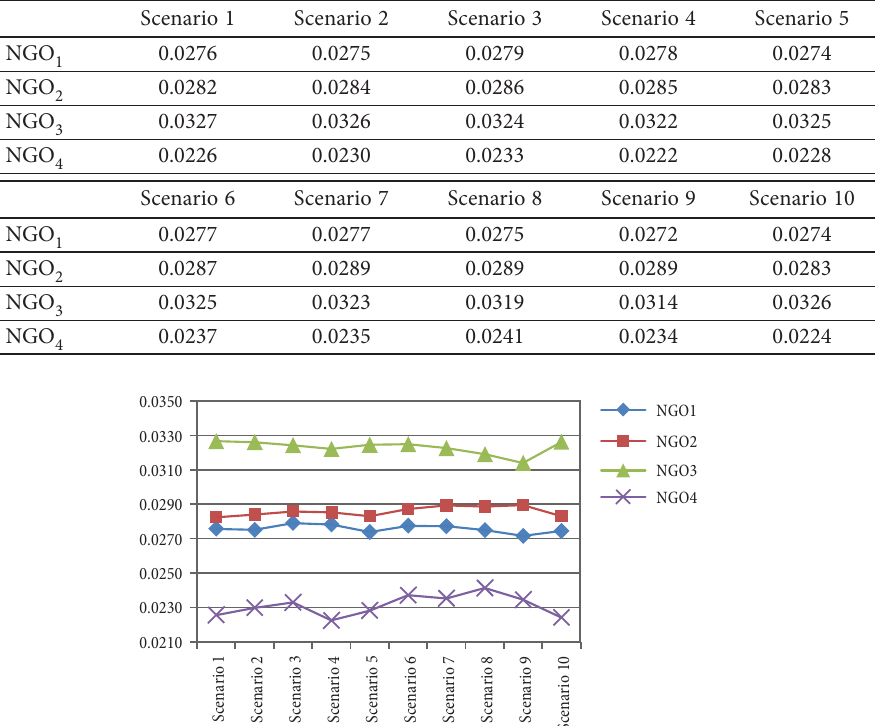
Table 12. The sensitivity analysis results